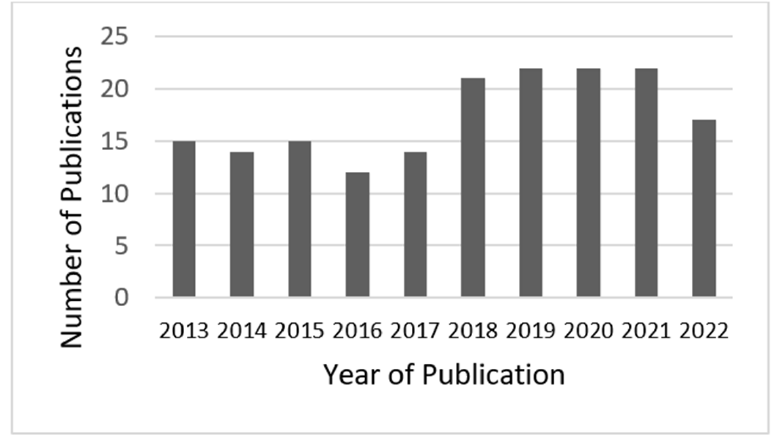
Figure 1. Publication volume of supercritical CO 2 assisted polylactic acid foaming from 2012 to 2022. Source: Web of Science.